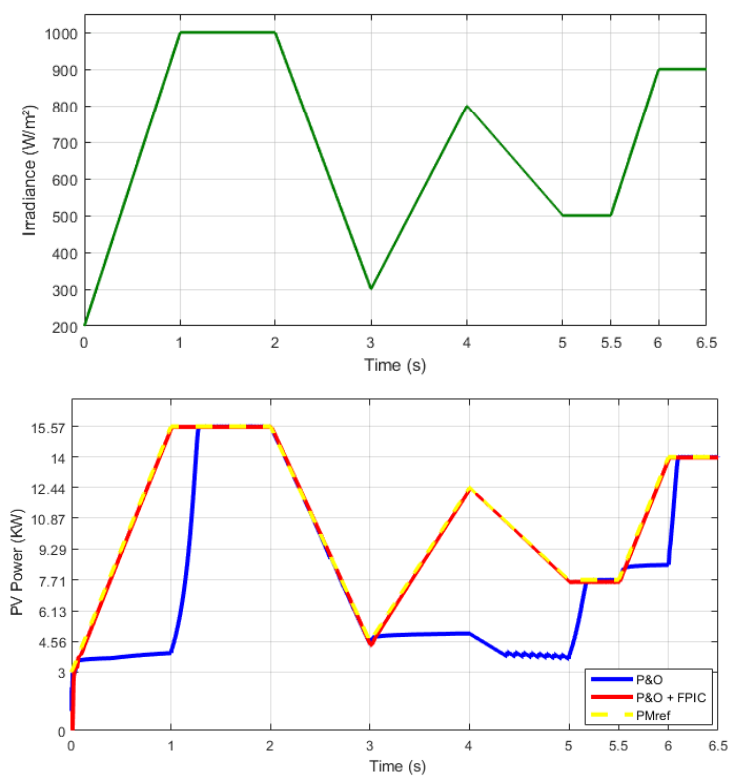
Figure 8. Simulation results of the proposed MPPT control strategy for the PVS.